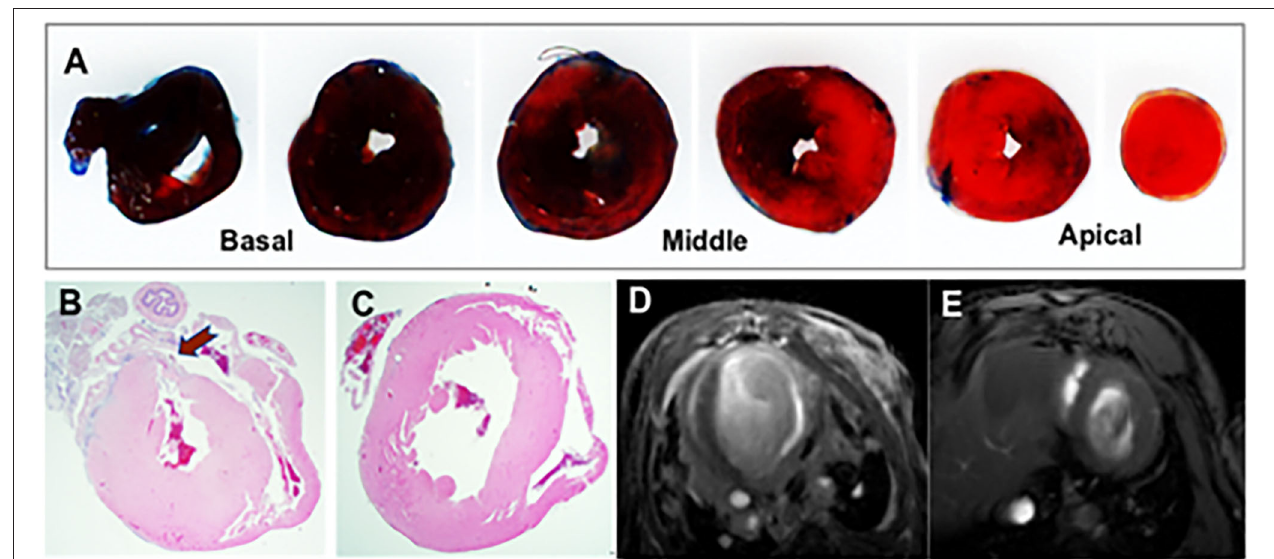
FIGURE 1 | Representative images from the mouse model of acute myocardial infarction (MI). (A) TTC stained mouse heart sections at 1mm after myocardial infraction. The viable myocardium appeared in blue and the area at risk (AAR) in bright red. (B) Histological demonstration of a thinned myocardium (shown by an arrow) in a mouse that underwent left anterior descending artery ligation. (C) Comparative histology from a normal control mouse. (D) Contrast-enhanced cardiac MRI showing anterior wall scar and wall thinning in a mouse model. (E) Cardiac MRI showing normal left ventricular